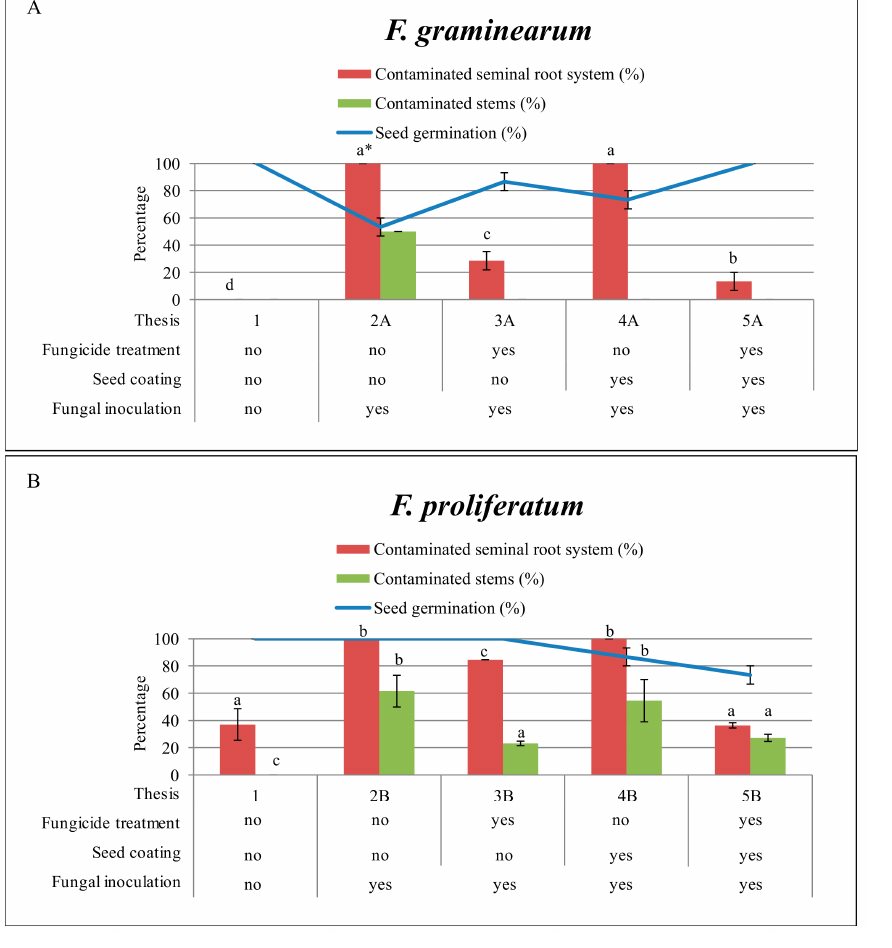
Figure 3. Percentage of seed germination and fungal contamination in maize seedlings grown in pots containing soil, after different and combined treatments (fungicide application, seed coating, fungal inoculation). Two separated experiments were carried out for F. graminearum ( A ) and F. proliferatum ( B ). * Values with different letters are statistically different with p < 0.05 as determined by one-way analysis of variance (ANOVA) followed by the Tukey